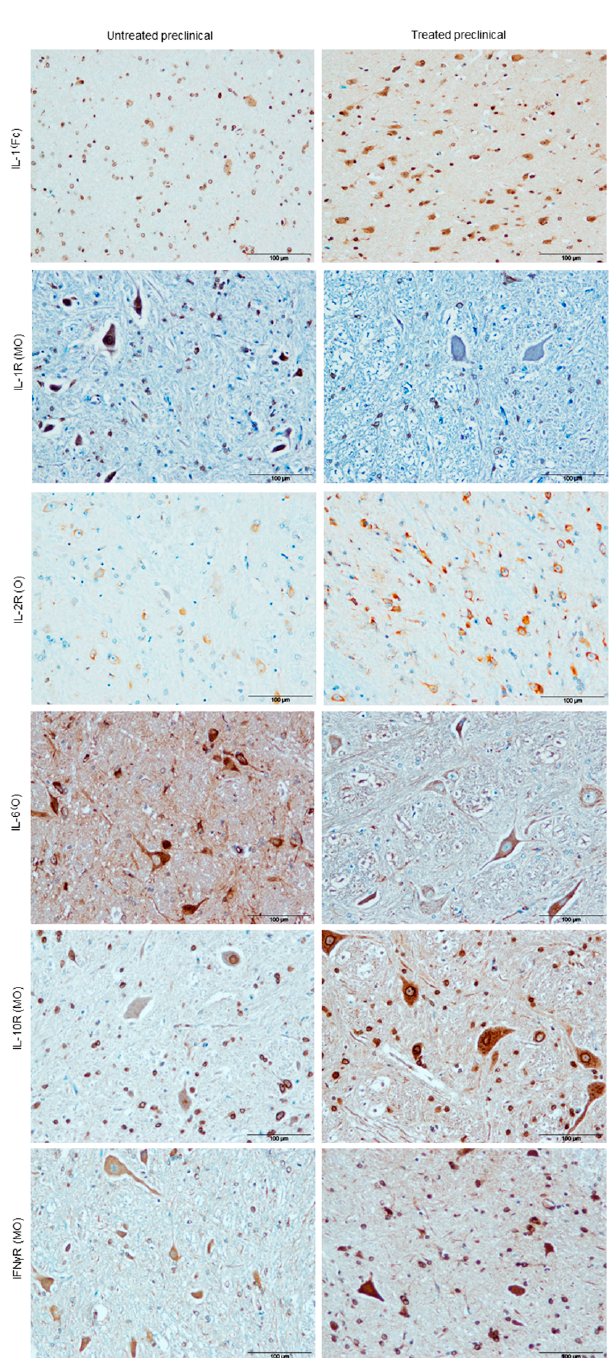
Figure 4. Illustration of cases (one area per case per marker) where differences in immunostaining for different cytokines (IL-1 α , IL-1R, IL-2R, IL-6, IL-10R and IFN γ R) associated with DEX treatment were evident. Scale bars: 100 µm. Frontal cortex (Fc), obex (O), medulla oblongata (MO). Thus, chronic glucocorticoid treatment applied in sheep in the preclinical stage of scrapie resulted in a remarkable reduction in vacuolation and pathological protein deposition (nearly null),